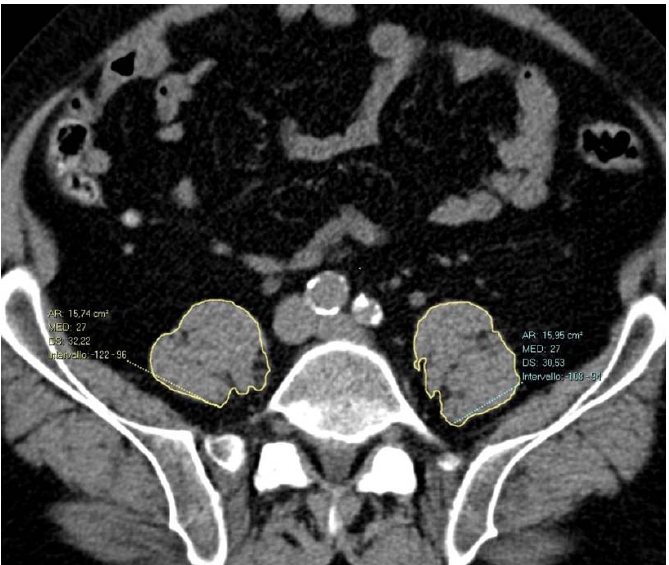
Figure 1. Axial non-enhanced CT scan showing polygonal manual segmentation (yellow outline of bilateral psoas muscles). The right psoas muscle area is 1574 mm 2 , and the left psoas muscle area is 1595 cm 2 . The PMD is 27 HU on both sides.